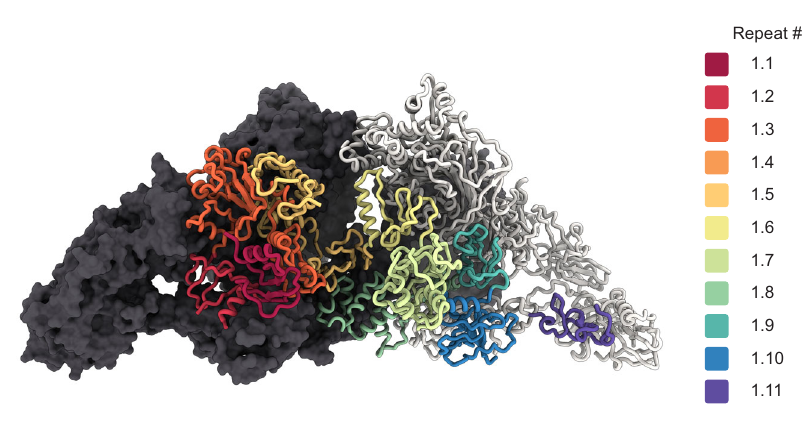
Fig. 2 Disposition of the different type 1 repeats in the hTG structure. Surface representation of one hTG monomer in the background-colored charcoal. Ribbon representation of the second hTG monomer in the foreground with each type 1 repeat colored as in the scheme on the right: non-type 1 repeats are colored in light